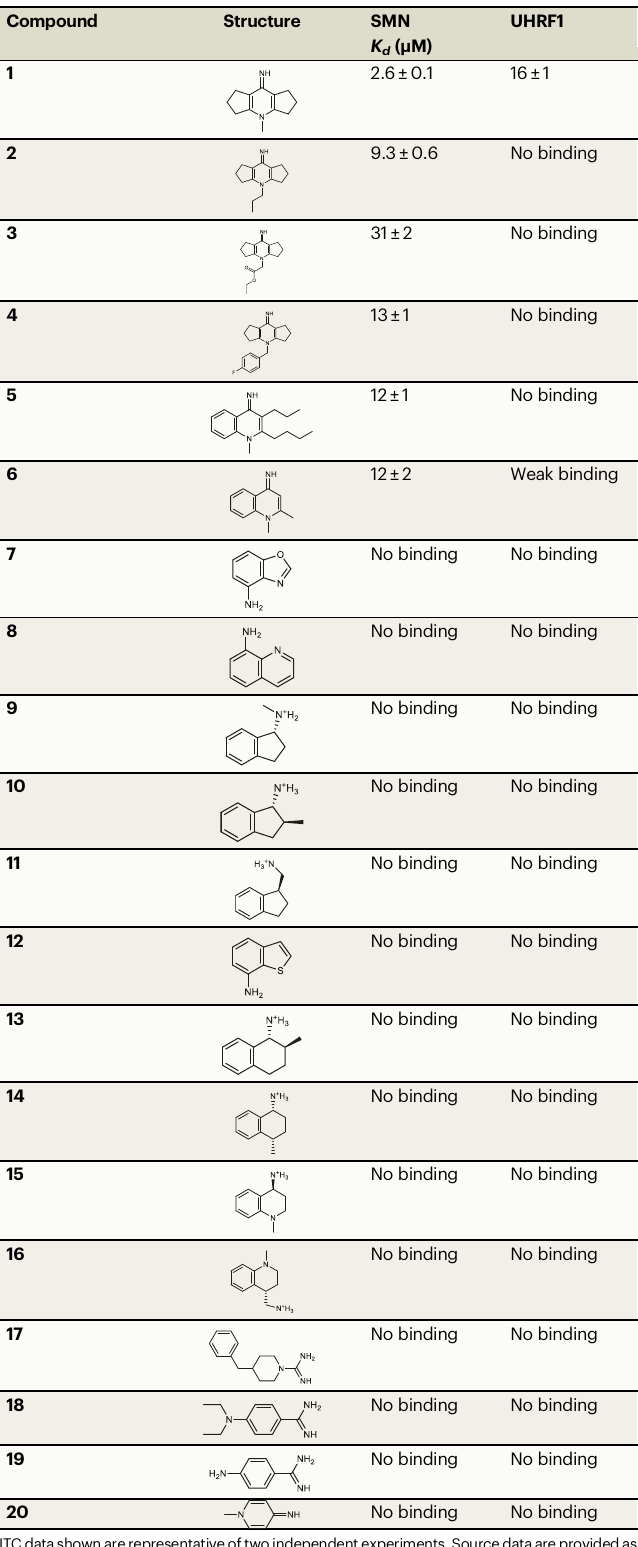
Table 2 | Binding af fi nities of compound 1 analogs reveal the importance of the triple-ring and imino group of compound 1